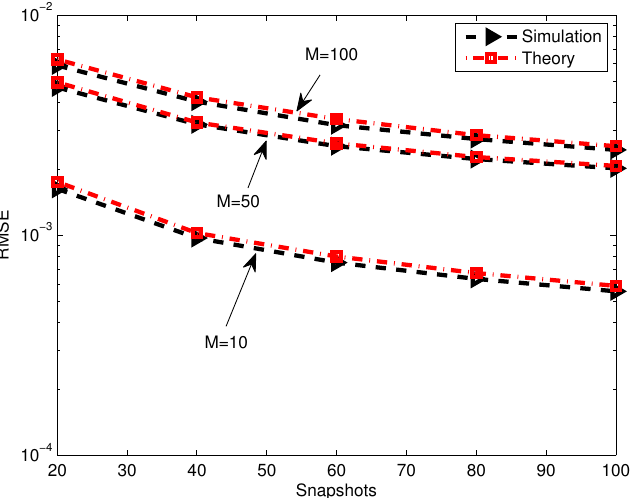
Figure 5. Gain-phase error estimation performance results of the proposed method versus snapshots, CSR = 30 dB, SNR = 40 dB, K 0 = 20.